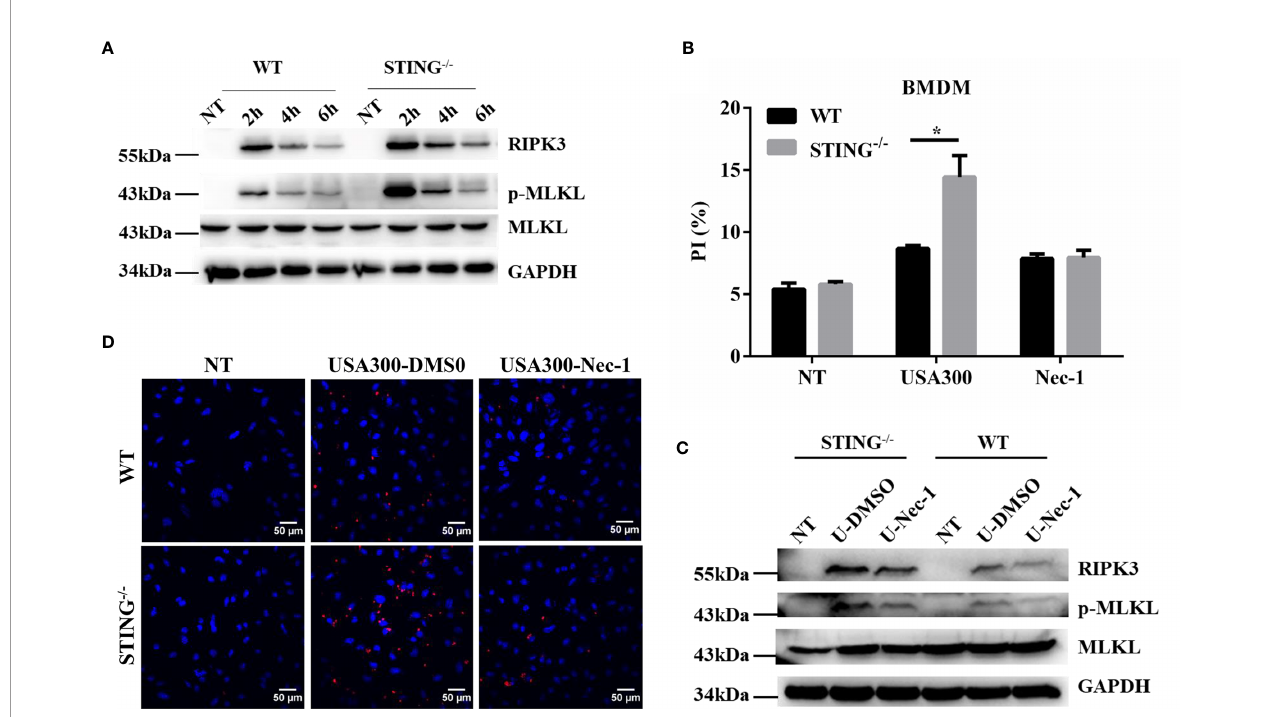
FIGURE 5 | STING reduces activation of necroptosis in macrophages following S.aureus challenge. (A, C) WT and STING -/- BMDMs were untreated or exposed to S.aureus at MOI=50 for the indicated time. BMDMs from WT and STING -/- mice were pre-treated Nec-1 (50 m M) or an equivalent amount of DMSO for 1 h prior to infection with S.aureus . The cellular lysate was analyzed for RIPK3, p-MLKL, MLKL, and GAPDH by western blotting. (B) Cell death was measured by PI staining in BMDMs infected with S.aureus at MOI=50 for 4 h. (D) BMDMs from WT and STING -/- mice were infected with S. aureus (MOI=50) for 4 hours, p-MLKL activation was observed through fl uorescence microscopy. All fi gures are representative of three independent experiments. Student ’ s t-test was performed. Statistical signi fi cance is indicated by *p <